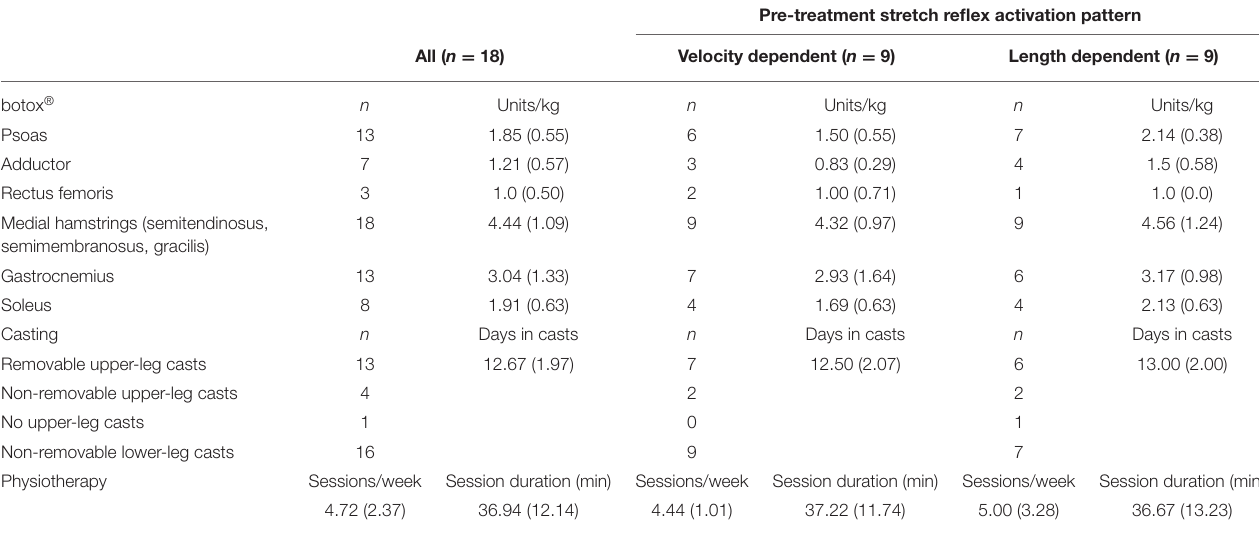
TABLE 2 | Treatment details: number of injected muscles, average amount (SD) of Botulinum neurotoxin-A (botox ® ) injected per muscle, number of subjects prescribed with upper leg casts and number of lower and/or upper-leg casts, average number of casting days, physiotherapy sessions per week and